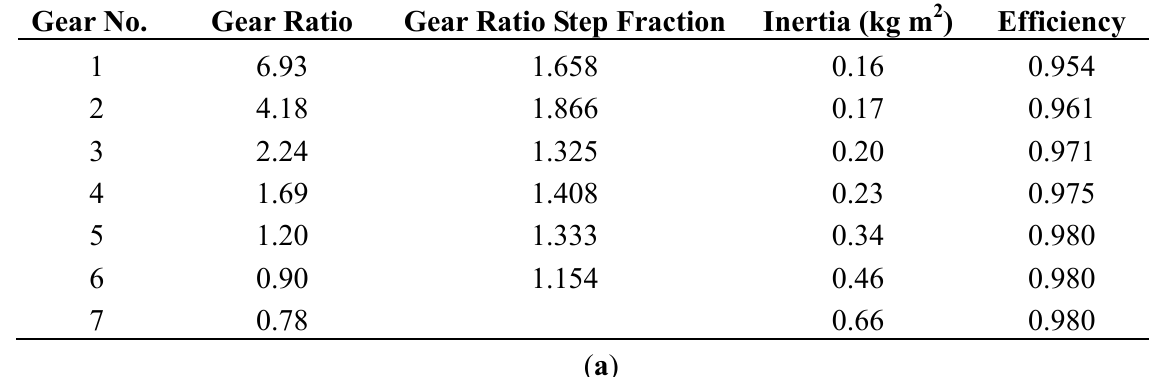
Table 3. Data of baseline seven-speed AT. ( a ) Gear ratio and efficiency; ( b ) Based shift schedule. Gear